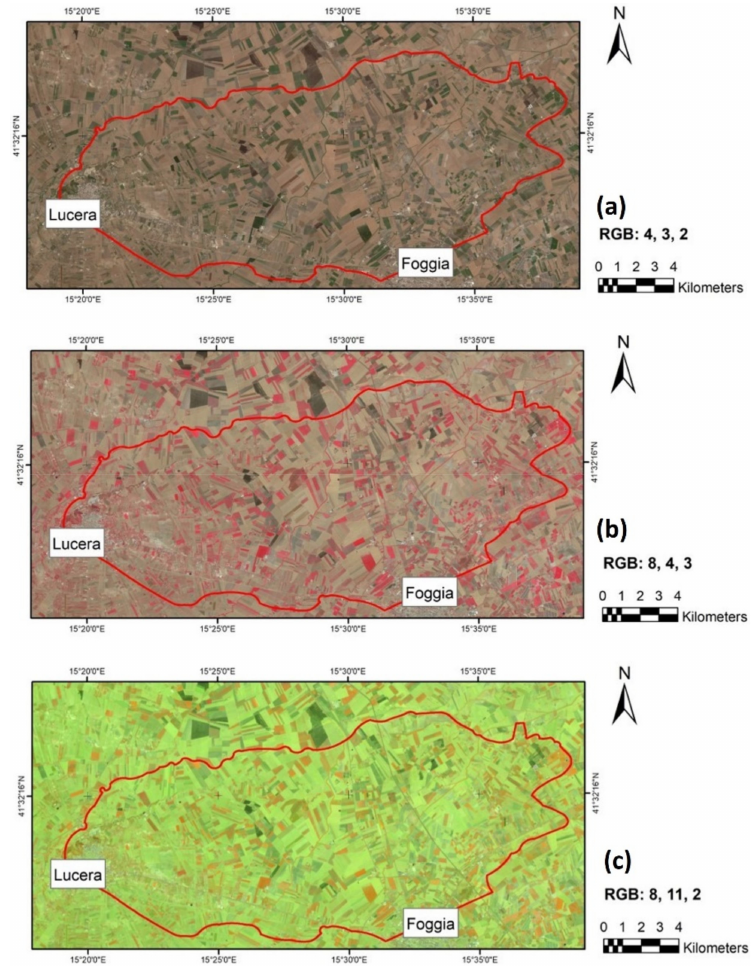
Figure 3. Outputs produced using Sentinel-2 bands: ( a ) RGB; ( b ) False Colour Infrared; ( c ) Healthy Vegetation